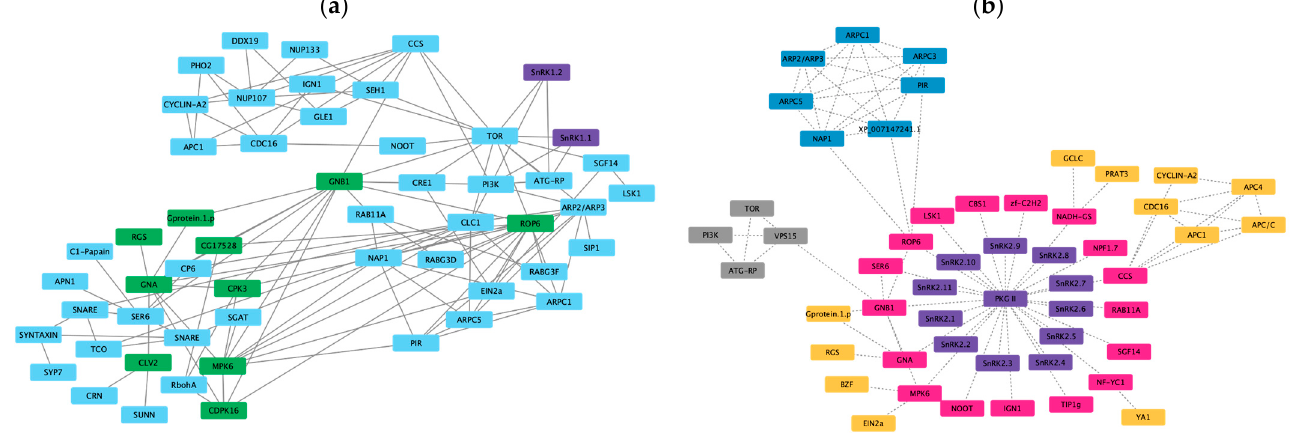
Figure 8. In silico prediction of protein–protein interactions among ( a ) SnRK1s and ( b ) SnRK2s with Scheme 11. Pv SnRK2 sub-family proteins with symbiosis-related proteins interact through 52 nodes and 81 edges. All Pv SnRK2 proteins interact with PKGII, which interacts with all other proteins shown in the network. Through CCS (Cell division Cycle 20 like protein) it interacts with cell cycle-related proteins such as Cyclin A2, CDC16 and APC (Anaphase-promoting complex) and through ROP6 interacted with ARP (auxin-related proteins). The prediction showed that few Pv SnRK2 sub-family proteins interact with symbiosis-related proteins (Figure 8b).